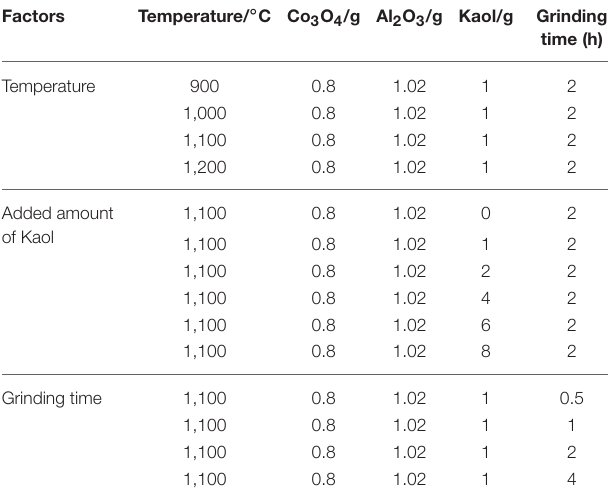
TABLE 1 | Conditions for preparation of the